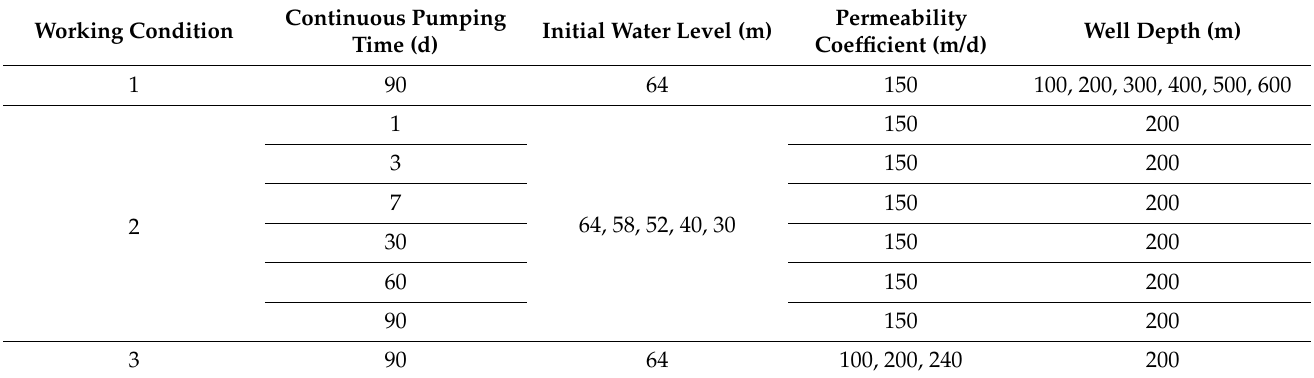
Table 3. Pumping capacity conditions of different factors.